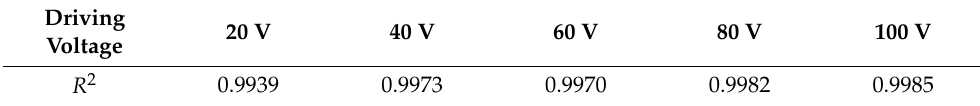
Table 5. Fitting degree of excellence in